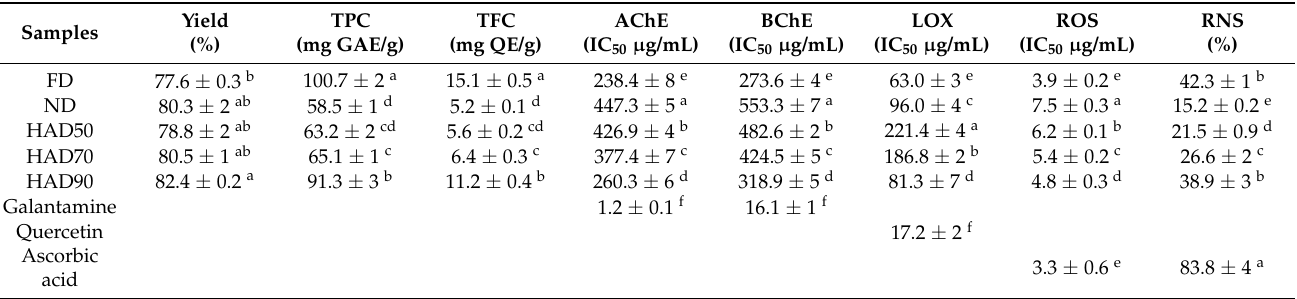
Table 3. Yield, TPC, TFC and neuroprotective potential evaluation of thinned peach extracts from PLE under optimized